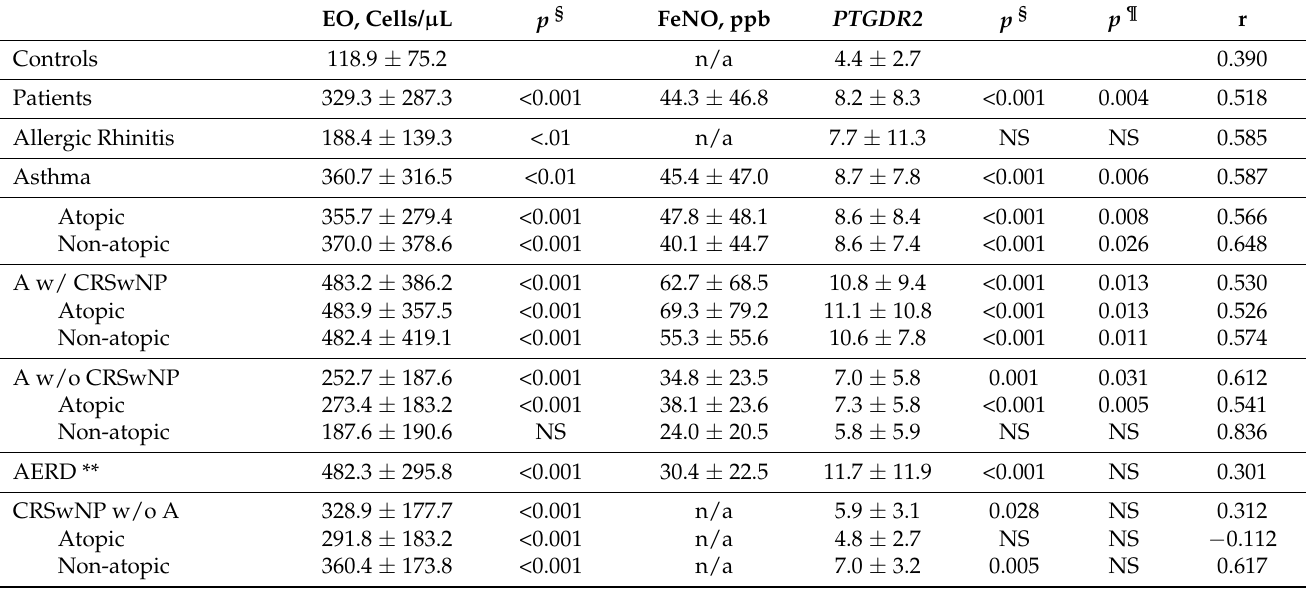
Table 5. Clinical characteristics of the population in the validation study.